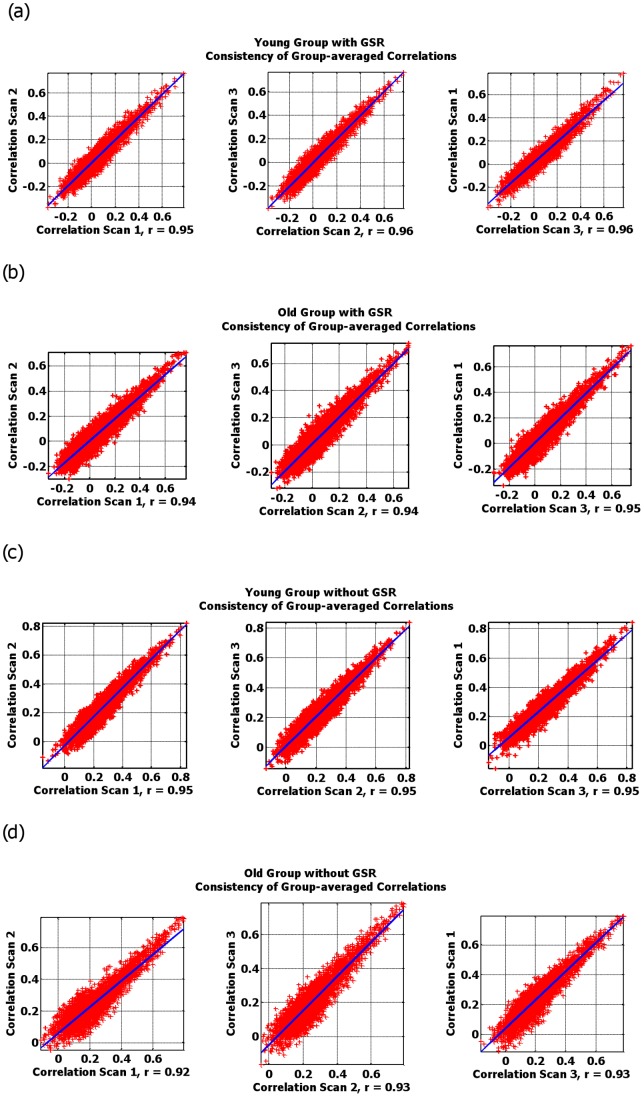
Scan 1 vs. scan 2 vs. scan 3.Group-averaged correlations from each scan session are plotted against each other. High consistency of RSFC from scan to scan is observed independent of aging and GSR factor. Overlaid blue lines represent linear regression fits of the data points and the r-values of the fit represent Pearson correlations of the data points.